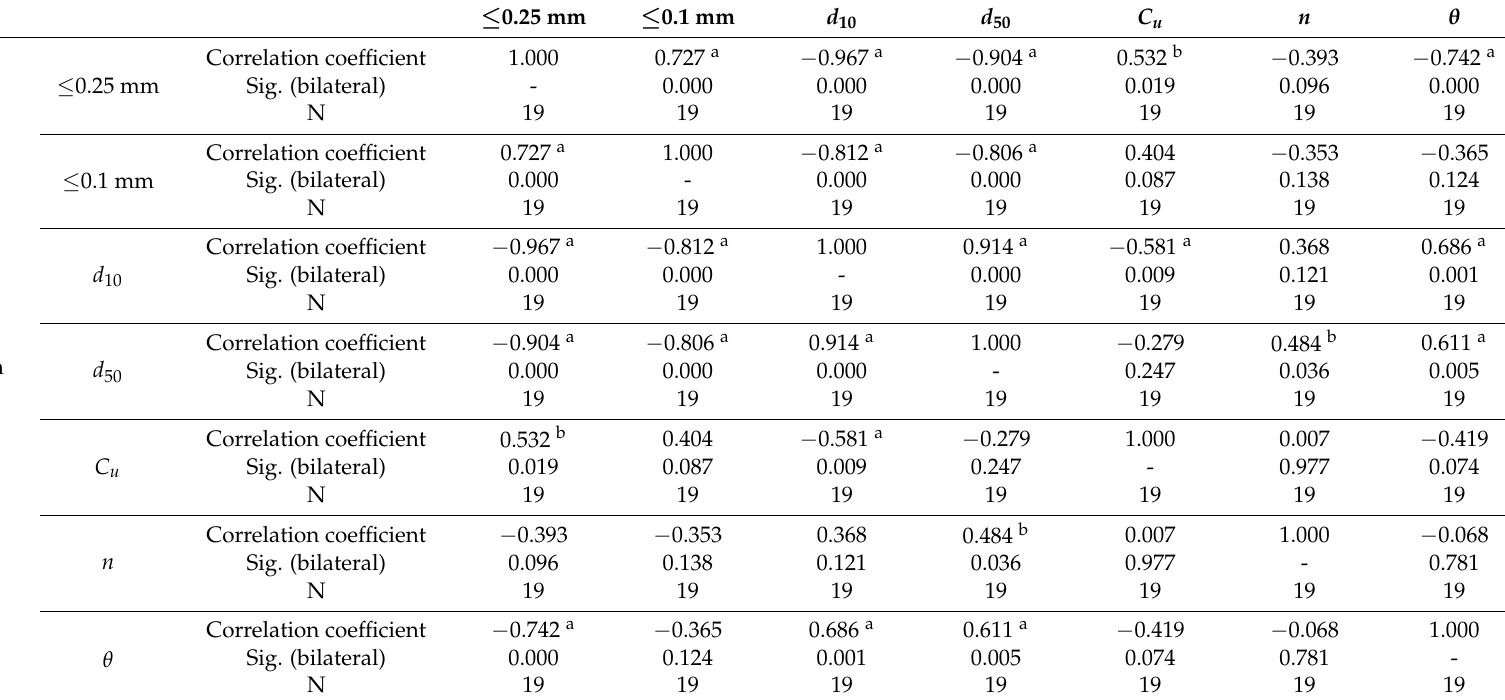
Table 4. Spearman grading correlation coefficient